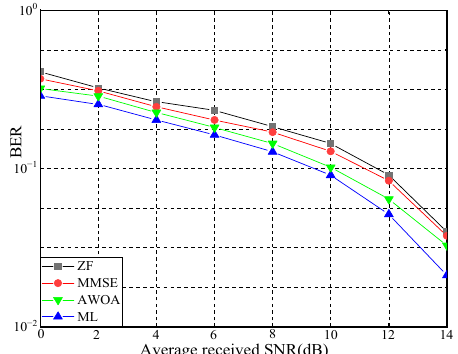
Figure 11. BER in 4*6 MI-MIMO. Figure 11. BER in 4 × 6 MI-MIMO.